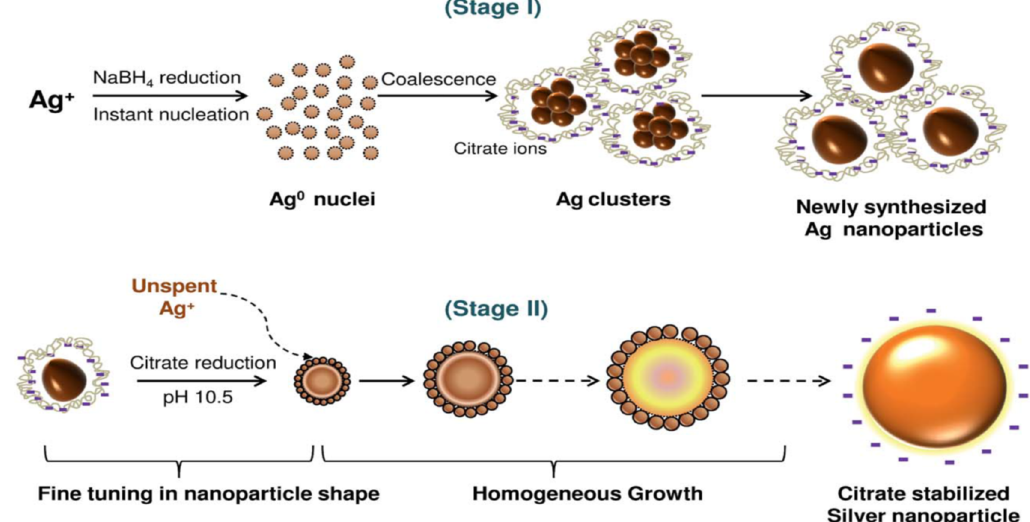
Figure 3. Schematic representation of size-controlled AgNPs synthesis employing the co-reduction strategy. Reproduced from [41], the Royal Society of Chemistry.